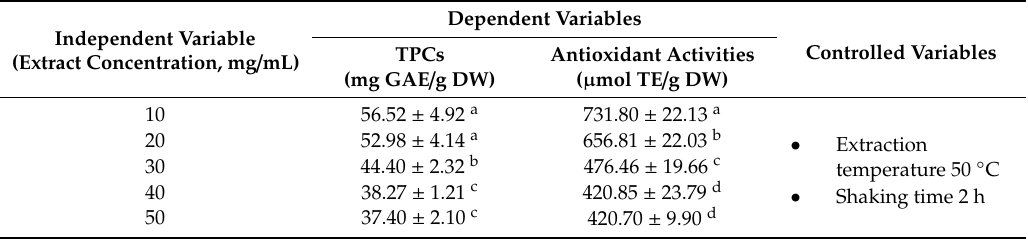
Table 1. E ff ects of di ff erent sacred lotus stamen extract concentrations regarding total phenolic contents (TPCs) and antioxidant activities determined by FRAP